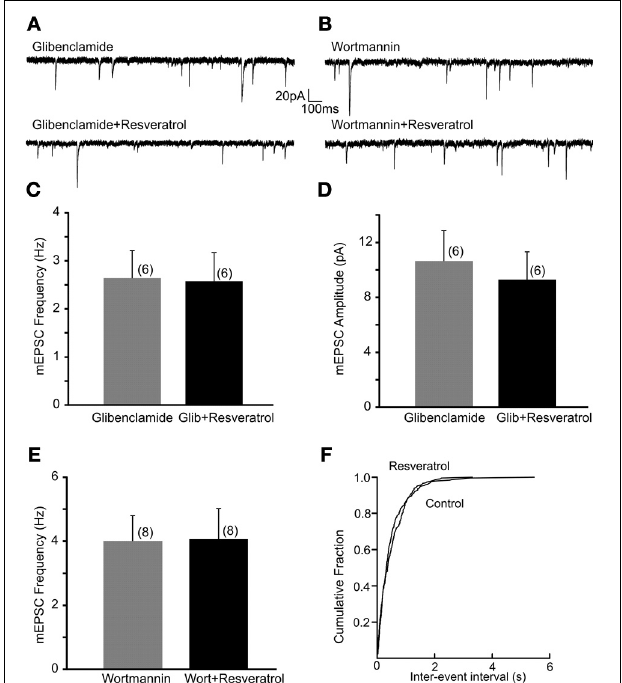
FIGURE 3 | Resveratrol increased excitatory neurotransmission through PI3-kinase activated K ATP channels. (A) Continuous whole-cell patch-clamp recordings of mEPSCs before (upper trace) and after (lower trace) resveratrol (100 µ M) application in the presence of glibenclamide (1 µ M). (B) Voltage-clamp recordings showing mEPSCs recordings before (upper trace) and after (lower trace) resveratrol application in the presence of wortmannin (1 µ M). (C) Combined data demonstrating that resveratrol failed to increase mEPSC frequency in the presence of glibenclamide. (D) Combined data indicating no change in amplitude of mEPSCs after resveratrol application in the presence of glibenclamide. (E) Combined data showing that resveratrol failed to increase mEPSC frequency in the presence of wortmannin. (F) Cumulative event probability plot of inter-event interval distribution in the recording shown in (B)